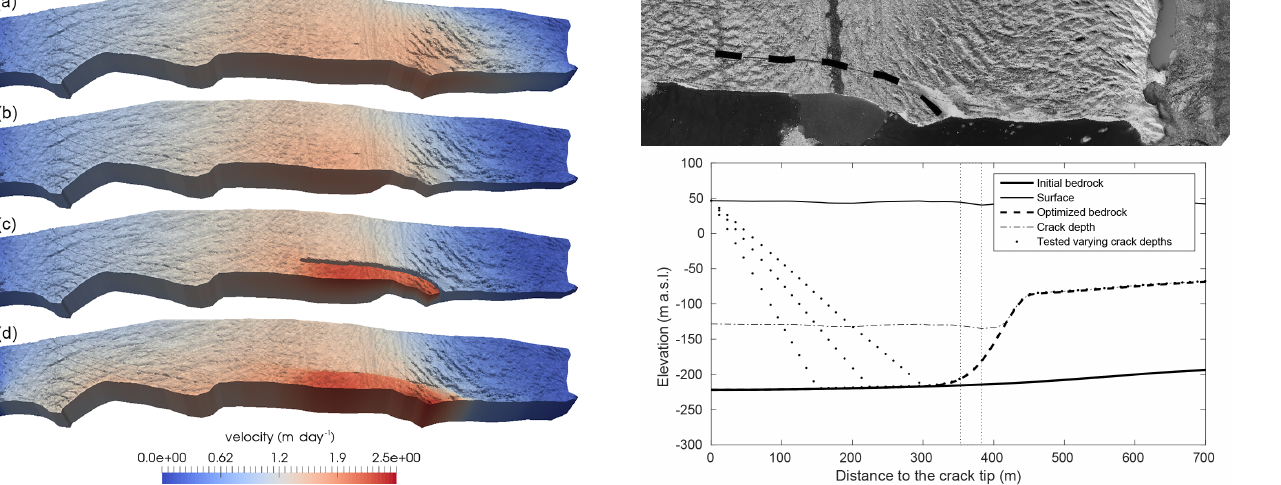
Figure 8. Top: inferred position of the crack on the orthoimage of 16 July (dashed line). Bottom: bedrock and ice surface along the main crack starting from the tip before and after optimizing the bump height and the crack depth to the UAV-inferred ice flow veloc- ities and tested varying crack depths. The dotted rectangle indicates the position where the crack crosses the